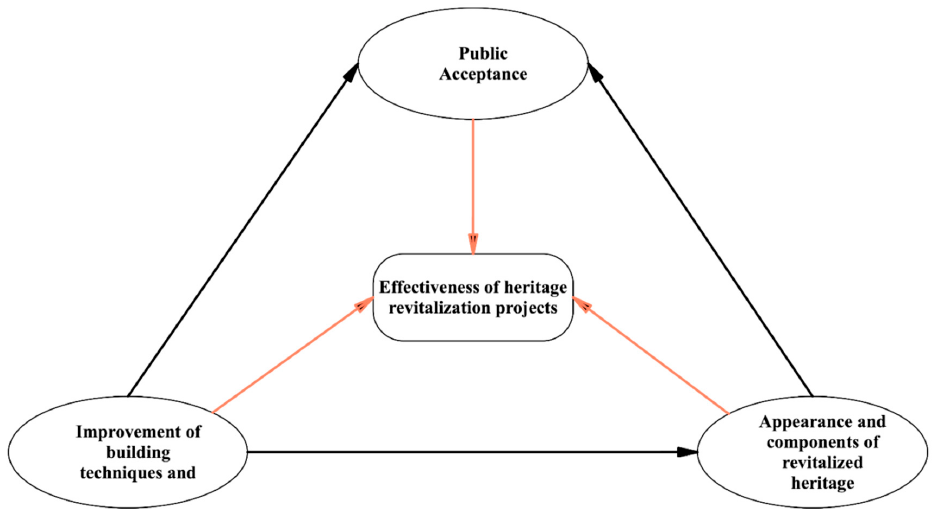
Figure 5. The influence relationship among three aspects.